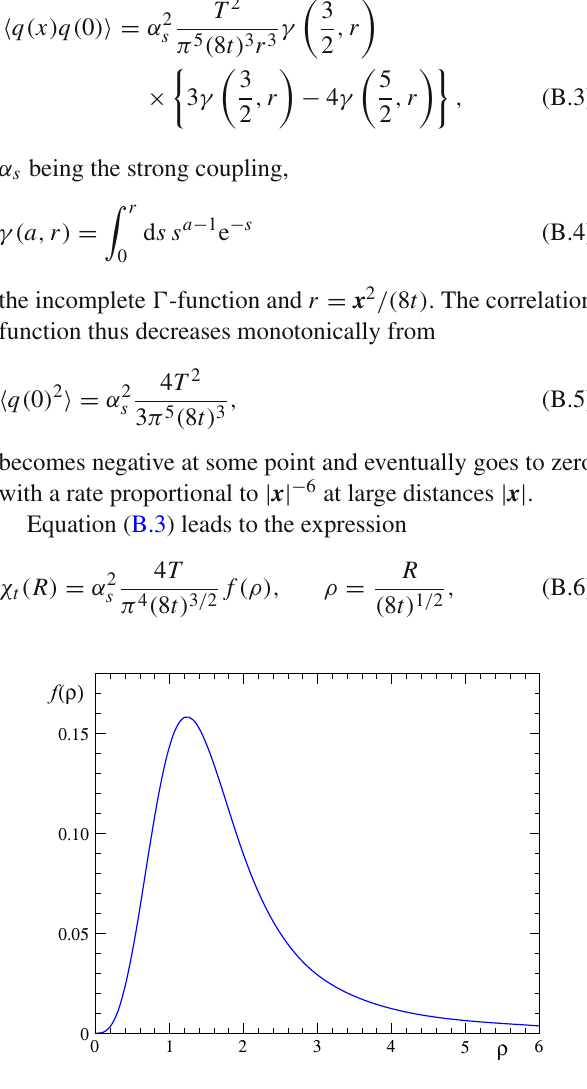
Fig. 6 The function (B.7) assumes its maximal value 0 . 1583 ( 1 ) at ρ = 1 . 236 ( 1 ) and decays like ρ − 3 at large